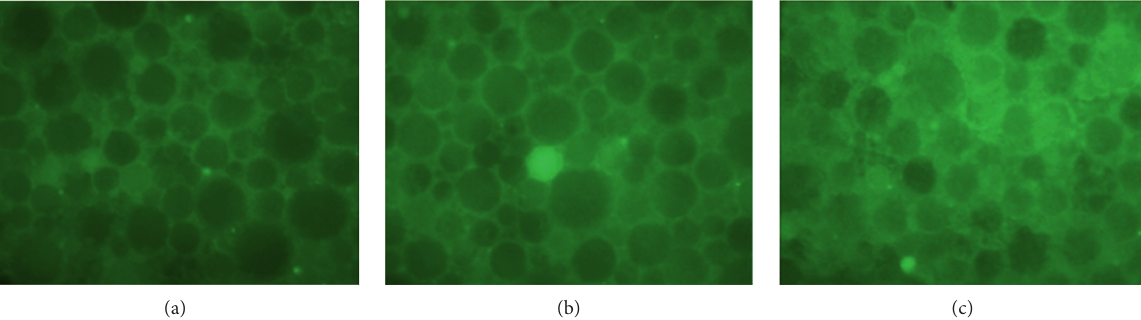
Figure 7: Microstructure of SBS latex with different T/S ratios: (a) 2.5:1, (b) 2.0:1, and (c) 1.5:1 (magnification: × 400).